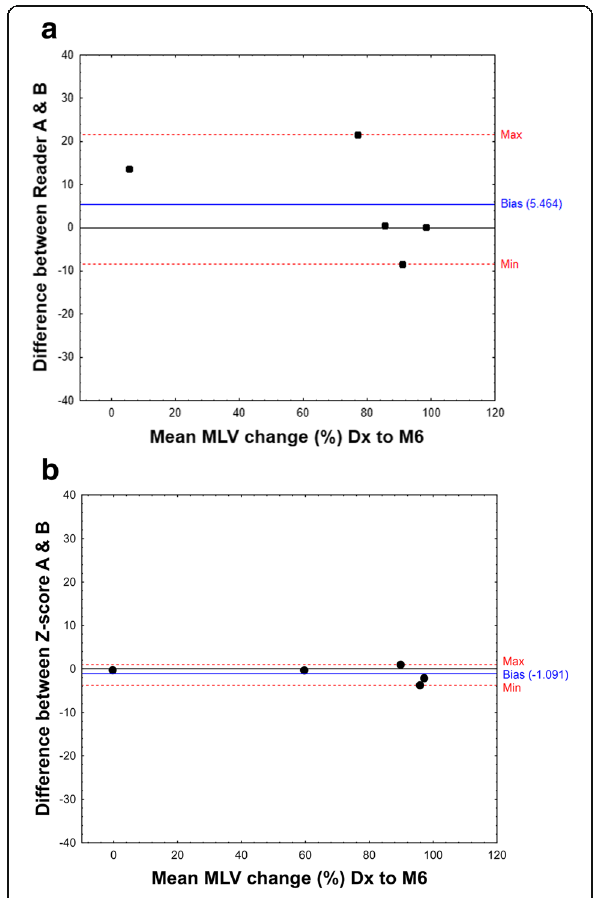
Fig. 5 Bland-Altman plots to show inter-user agreement between the mean percentage change in metabolic lesion volume from diagnosis to month 6 of treatment. a Manual segmentation of reader A and reader B. b Z -score segmentation created using normal lung and lung masks defined by user A and user